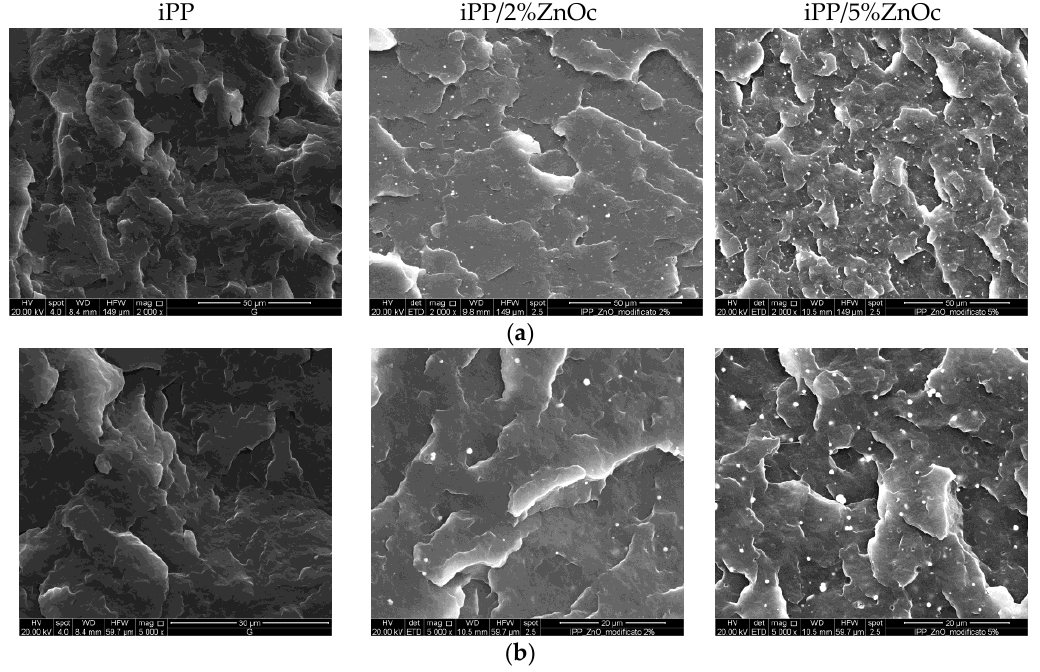
Figure 7. Micrographs of iPP and iPP/ZnOc pellets fractured in liquid nitrogen at magnification ( a ) 2000× and ( b ) 5000×.